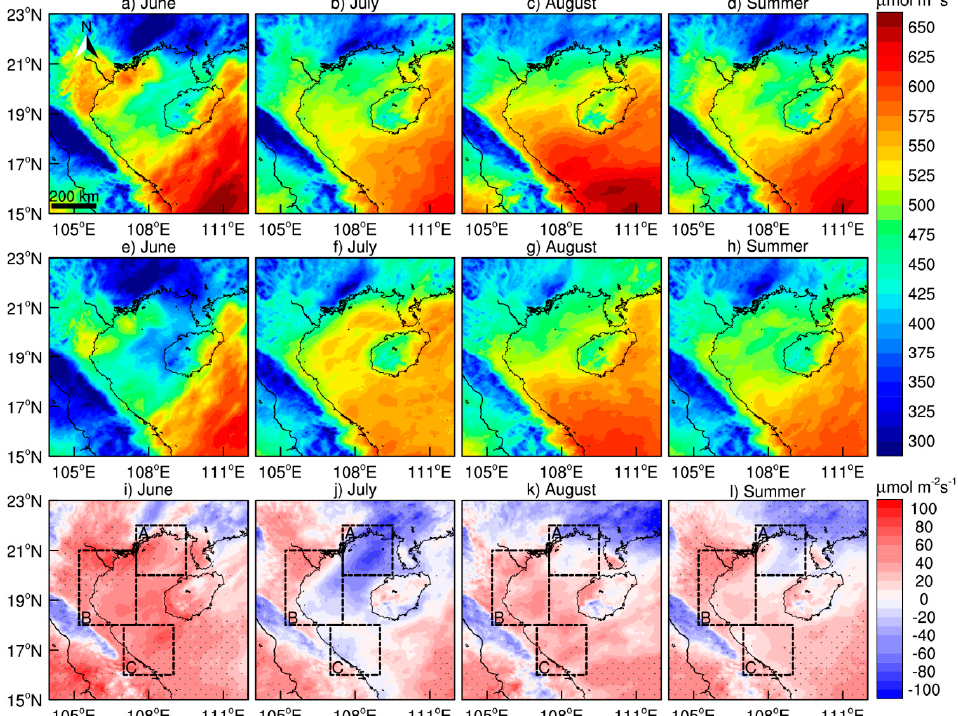
Figure 7. Same as Figure 4 but for photosynthetically active radiation (PAR).